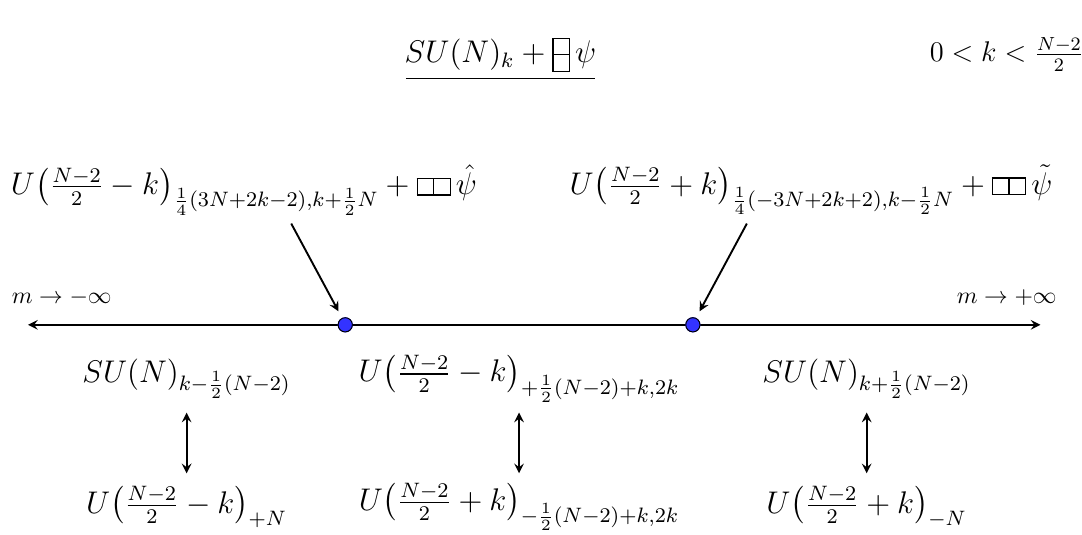
Figure 4 . Phase diagram of SU( N ) with an antisymmetric fermion for 0 < k < N (cid:0) 2 circles represent a phase transition between the asymptotic phases and the intermediate quantum phase. Each phase transition has a dual gauge theory description, which appears with an arrow pointing to the phase transition. The mass deformations are related by m = (cid:0) m ^ and m = (cid:0) m ~ .